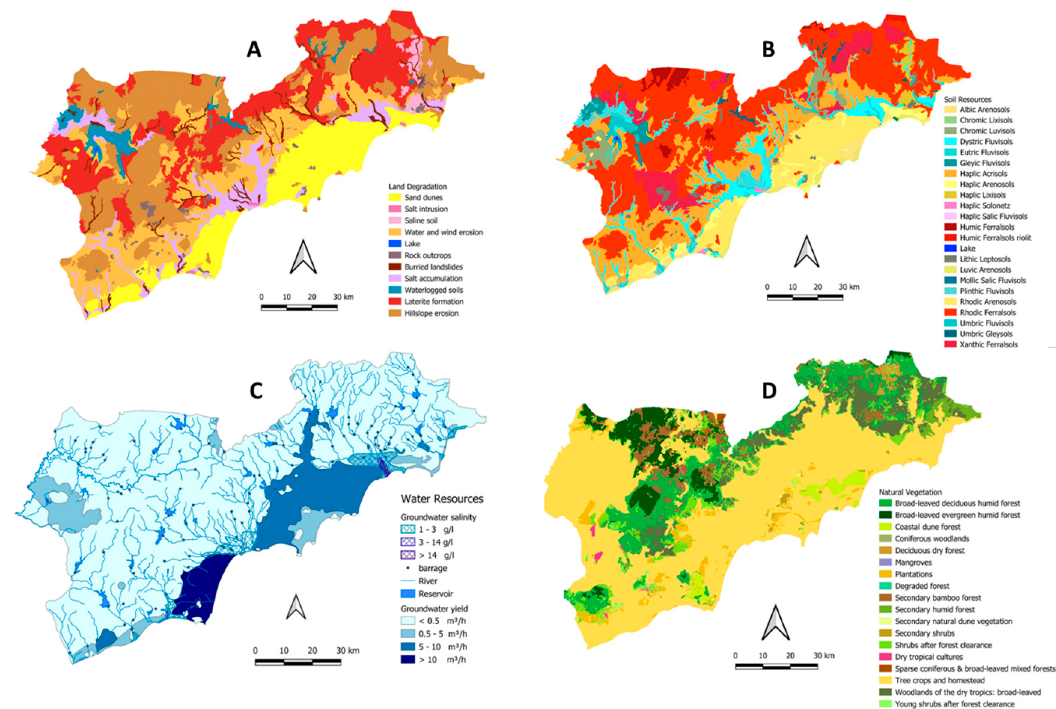
Figure 4. Land degradation and natural resources of Binh Thuan province, Vietnam. ( A ): land degradation, ( B ): soil resources, ( C ): water resources, ( D ): natural vegetation.